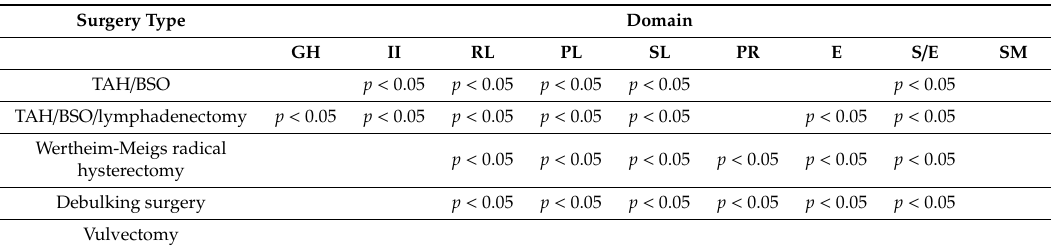
Table 8. Impact of the mode of surgical treatment performed on the prevalence of urinary incontinence symptoms and impact on patients’ everyday life measured by the various KHQ domains (Wilcoxon’s signed-rank